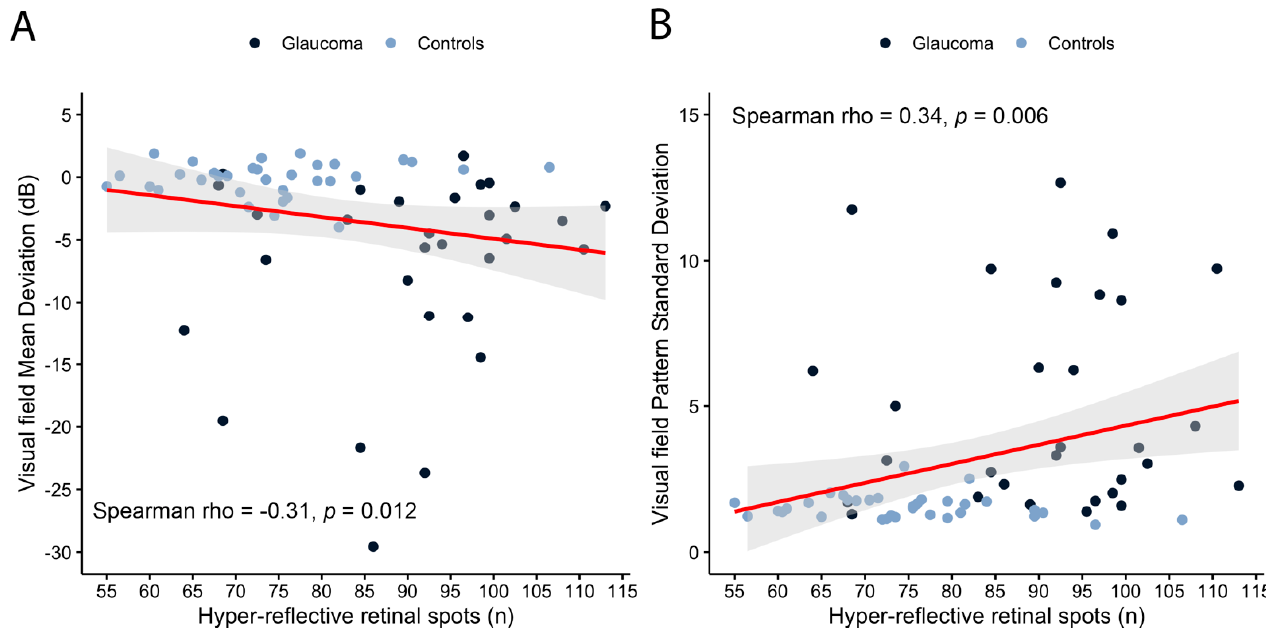
Figure 2. Scatterplot of hyper-reflective retinal spot number vs. visual field mean deviation (MD, ( A )) and pattern standard